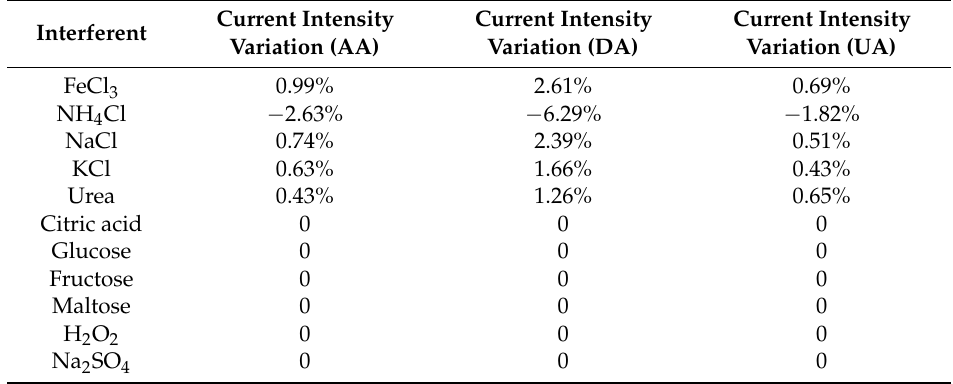
Table 1. Results of interference study on the response of ascorbic acid (AA), dopamine (DA), and uric acid (UA).